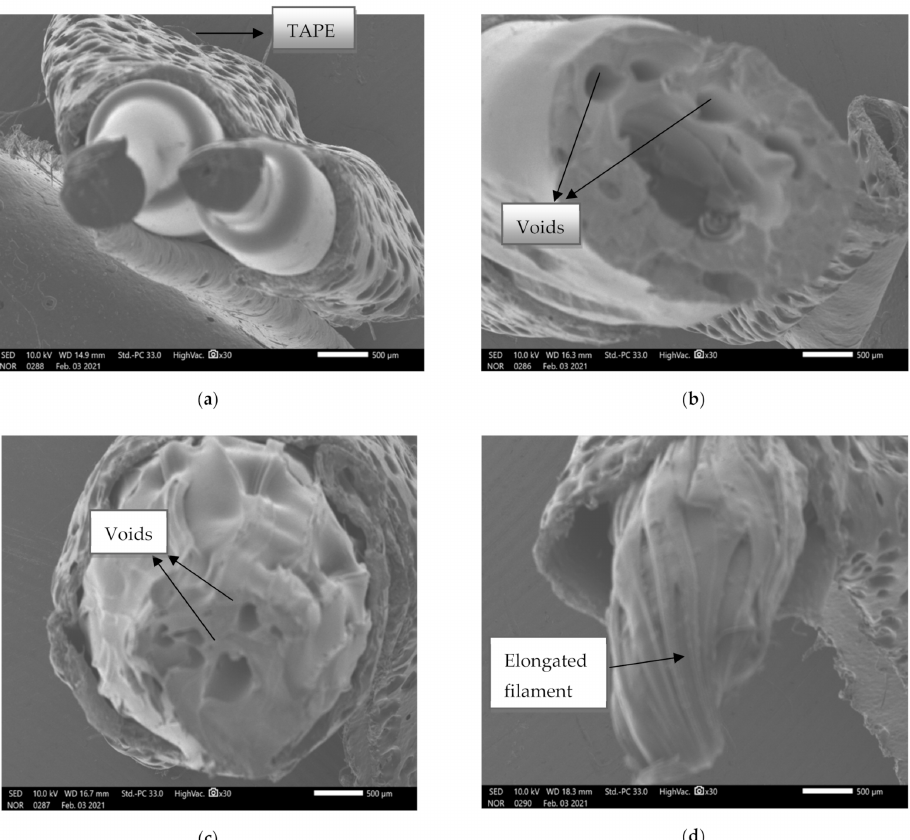
Figure 18. SEM Images of ( a ) C2 , ( b ) B4 , ( c ) B10 , and ( d ) C8